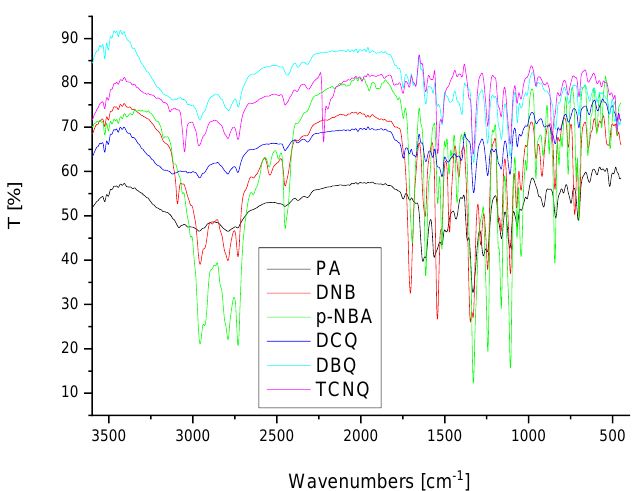
Figure 1. FTIR spectra analysis of FXN drug generated with six π -acceptors.